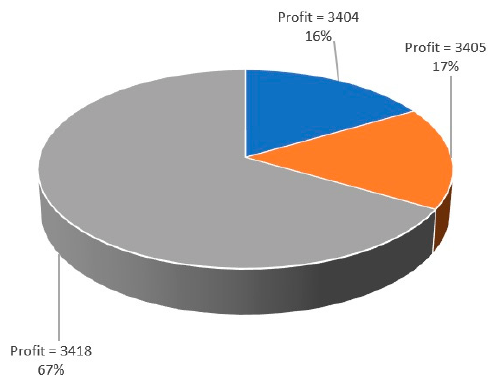
Figure 6. Percentages of solutions for the Hp1 instance with 30 runs of the SA algorithm.